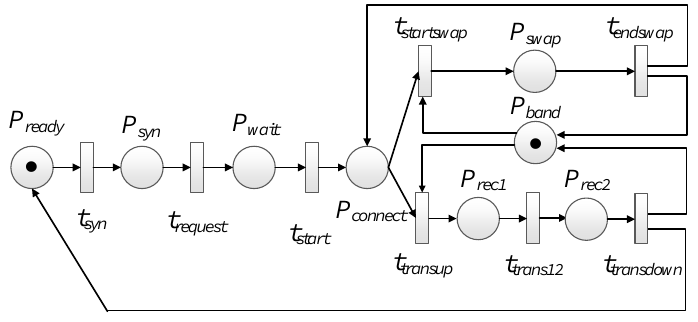
Figure 8. SPN model for satellite networks based on Moving Target